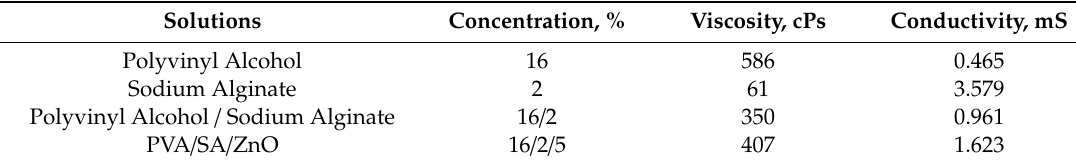
Table 2. Main properties of solutions for electrospinning.